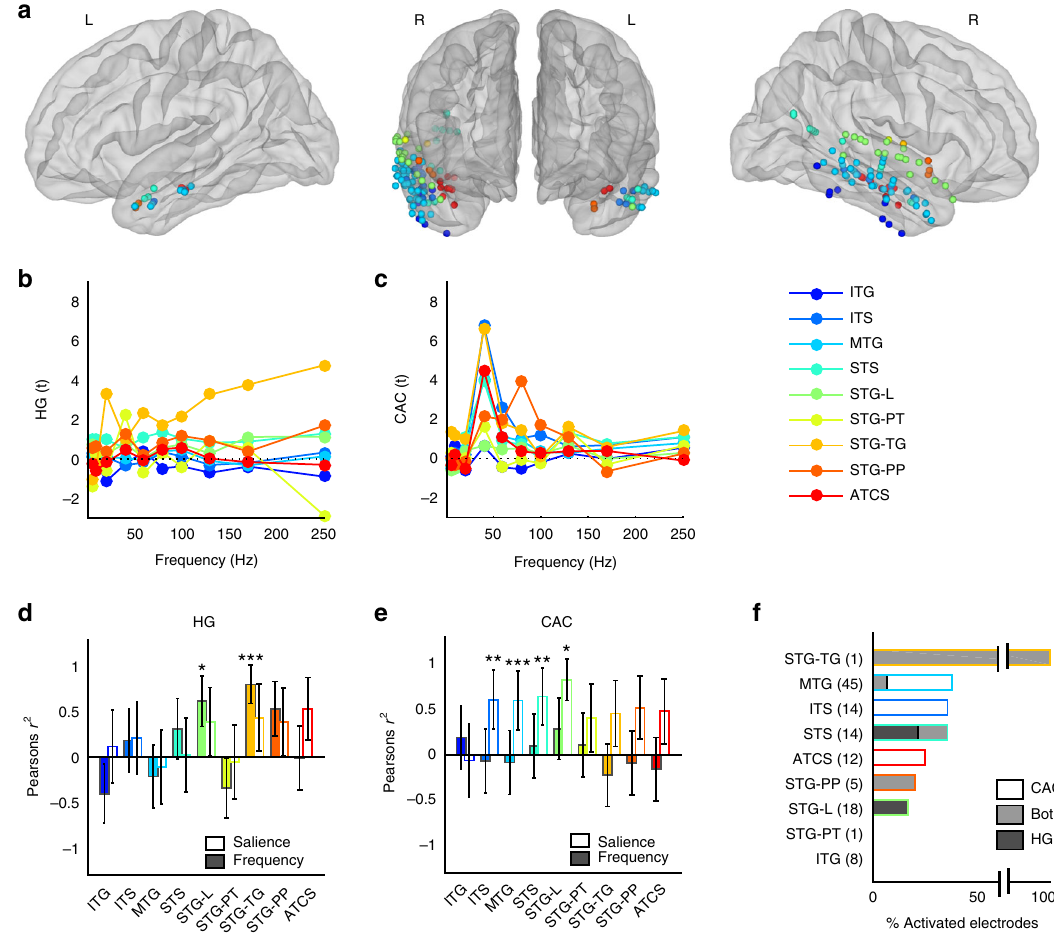
Fig. 3 HG and CAC response patterns in anatomically de fi ned sub-regions of the temporal lobe. a Anatomical and functional categorisation of electrodes in the temporal lobes, based on the Destrieux anatomical parcellation. b HG responses in onset [0 – 0.4 s] window (expressed in t -values relative to the baseline) averaged within regions and across participants at each stimulus frequency. c Same as in b. for CAC in late [0.8 – 1.8 s] window. d Pearson ’ s correlation value (r 2 ) between onset HG responses and stimulus frequency (coloured fi lled bars) and salience (empty bars). Error bars indicate SE of the correlation. e Same as in ( d ) for CAC. f Proportion of activated electrodes exhibiting signi fi cant HG onset response (dark shading), sustained CAC (no shading) or both (grey shading) in each network. Numbers on the y-axis indicate the number of electrodes located in each regions. *, ** and *** indicate signi fi cant (corrected) p -values at 0.05, 0.01 and 0.001, respectively. ITG Inferior Temporal Gyrus, ITS Inferior Temporal Sulcus, MTG Middle